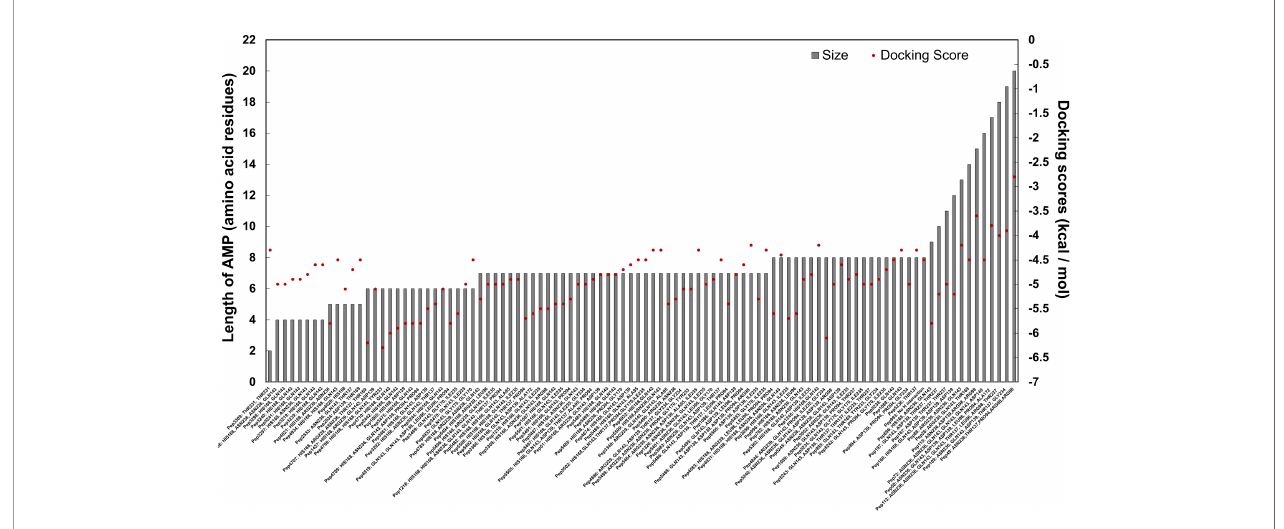
FIGURE 5 | In silico molecular docking scores and interacting residues for 100 candidate AMPs and the semi-open conformation of the C. striatum sortase C protein. AMPs were predicted to interact with the putative active site triad residues, protruding residues near the triad as well as residues further away from the